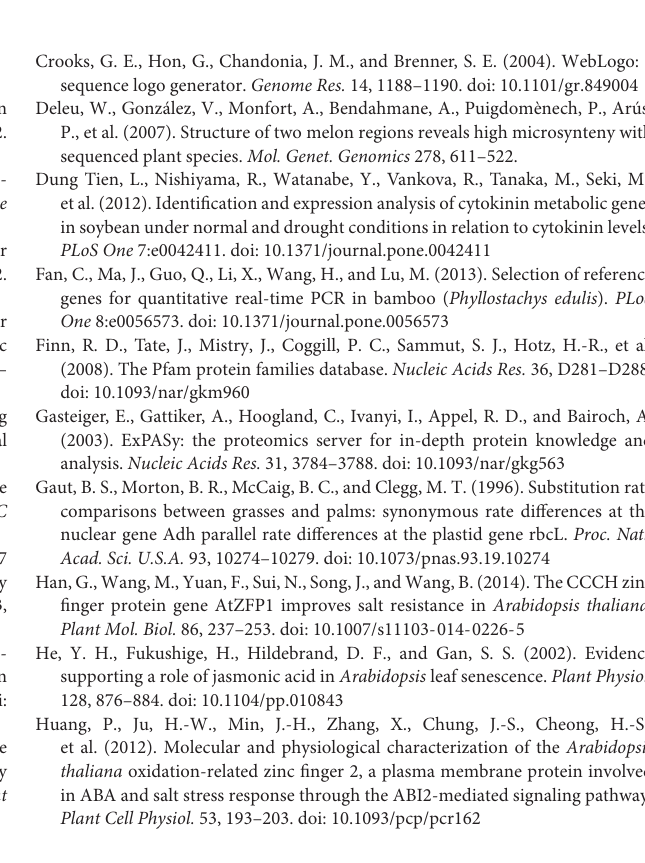
Supplementary Figure 2 | Schematic representation of the15 conserved motifs in PeC3Hs . Conserved motifs of the PeC3Hs were identified using the online MEME program based on 119 full-length amino acid sequences with the following parameters: maximum number of motifs, 10; maximum width, 100. The lengths and positions of different motifs in the protein sequences are identified by the lengths and positions of the different color blocks. Supplementary Figure 3 | Gene structures of CCCH in moso bamboo. Gene structures were performed using the Gene Structure Display Server online tool.